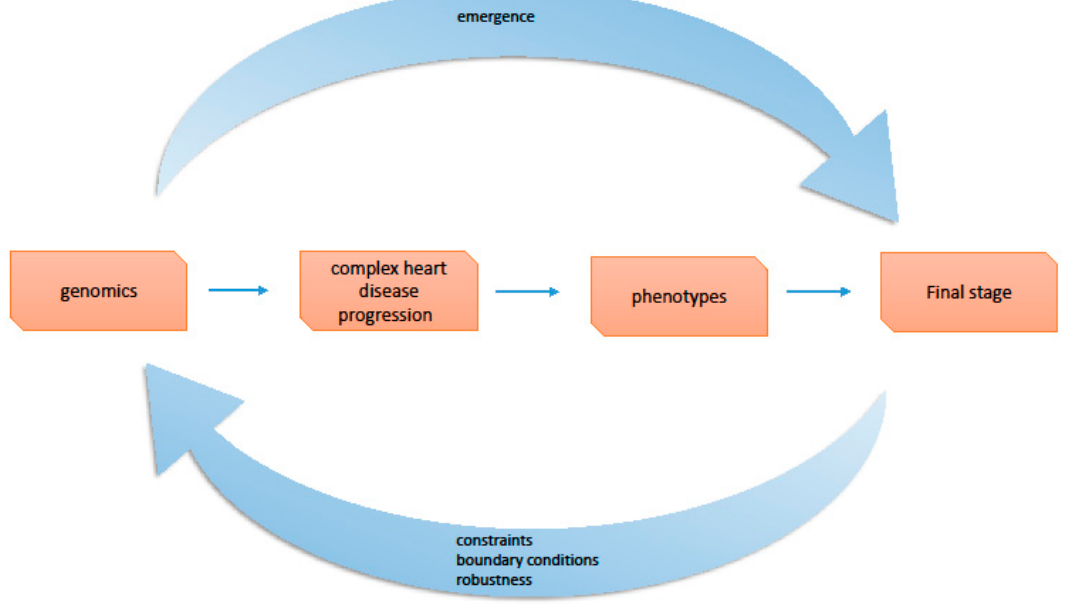
Figure 2. Progression of complex heart diseases: Relationship between emergent properties and constraints outlines progression of complex heart diseases.